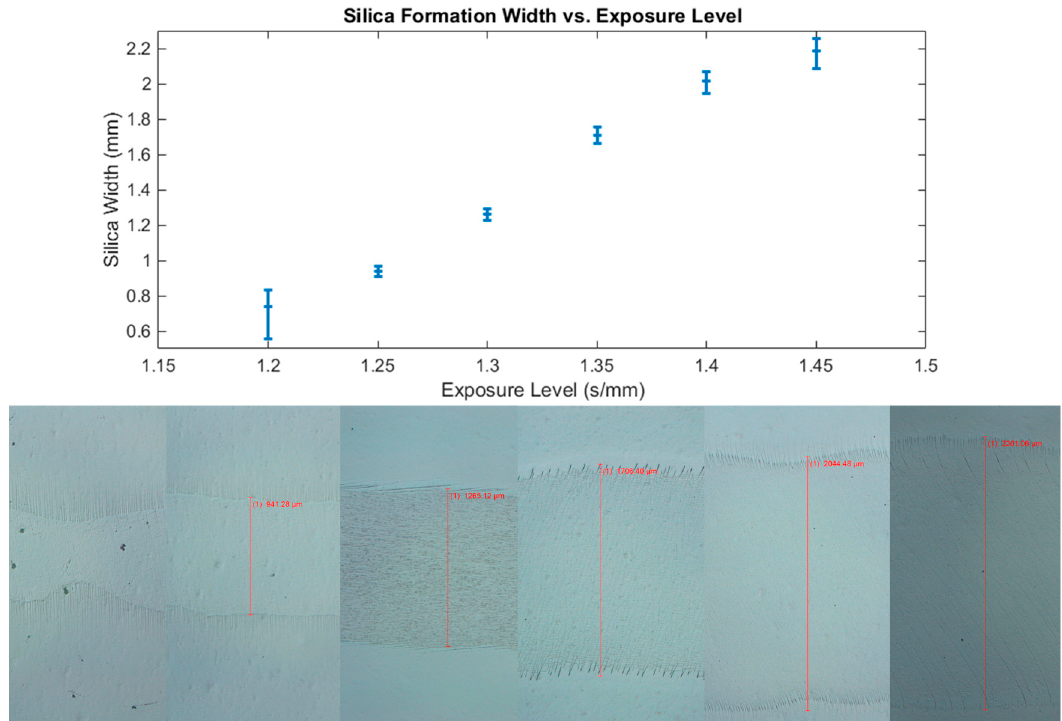
Figure 9. Measured width of silica formation at 6 exposure levels with examples of each.